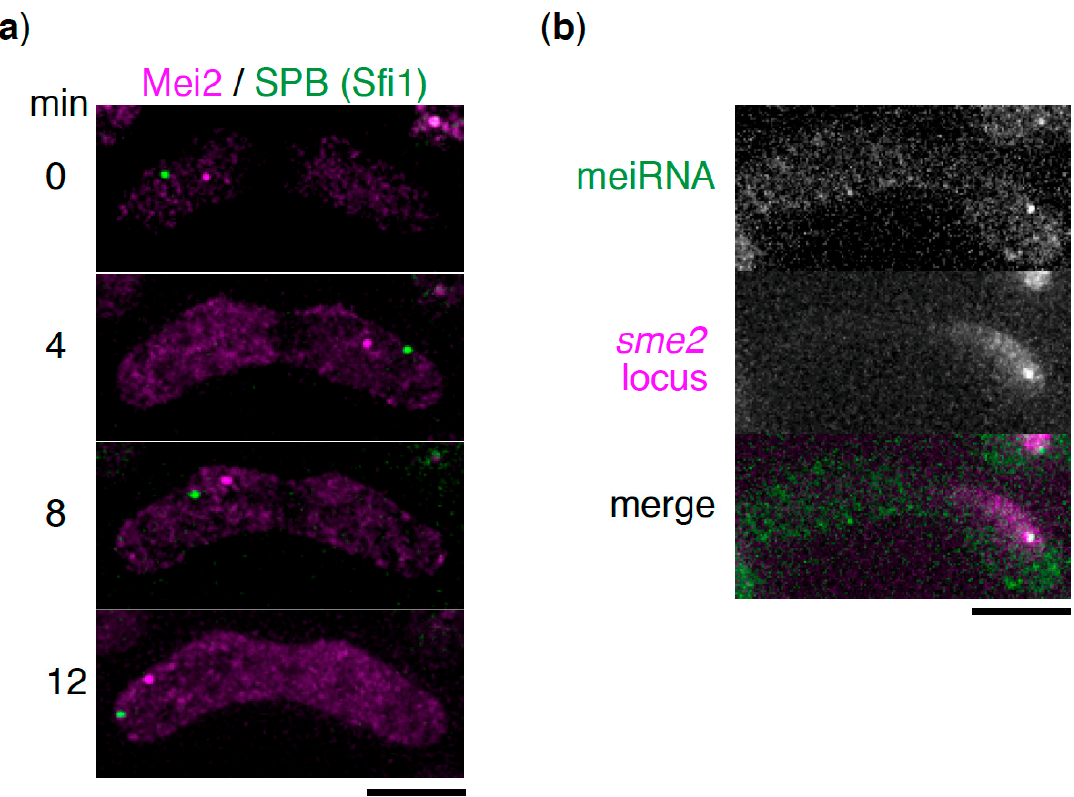
Figure 2. meiRNA forms a chromosome-associated dot structure in cooperation with its binding partner, Mei2. ( a ) Time-lapse images of Mei2 (magenta) and the spindle pole body (SPB) (Sfi1, green) during the horsetail movement. Scale bar: 5 µm. ( b ) Localization of meiRNA. meiRNA was visualized by the MS2 system, in which MS2-loop-tagged meiRNA and MS2-YFP were expressed (green) [6]. The sme2 locus was marked by inserting lacO repeats and expressing 4xmCherry-LacI-NLS (magenta). Scale bar: 5 µm.